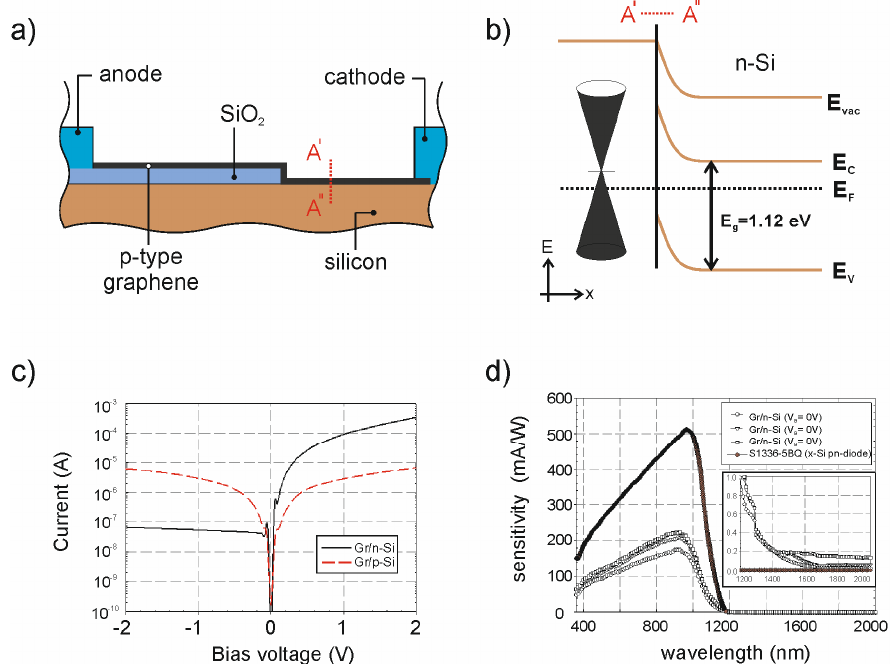
Figure 3. ( a ) Schematic of a graphene/Si heterojunction PD; ( b ) schematic of the band structure of the device in (a); ( c ) I-V curves of graphene-Si diodes on n-type (black solid line) and p-type (red dashed line) Si substrates; ( d ) comparison of the bias-dependent spectral response of a graphene/Si PD with a state-of-the-art bulk p-n junction Si PD. Inset: magnification of the spectral response in the IR region, where the response is entirely due to the graphene [57].